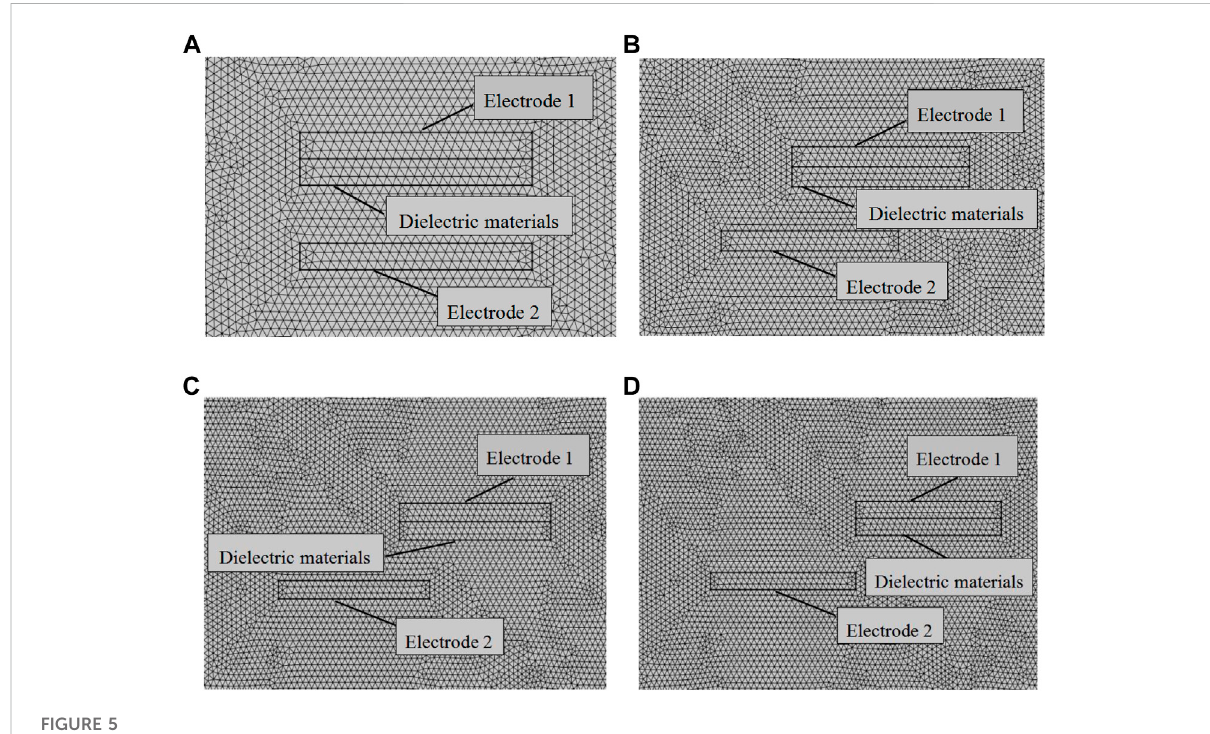
FIGURE 5 Geometric meshing of